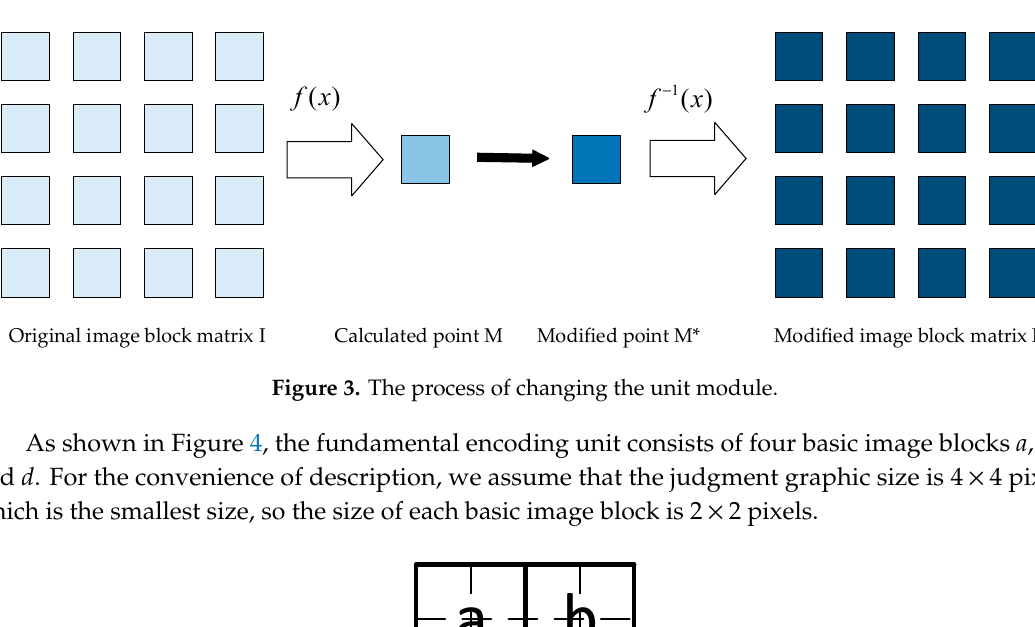
Figure 4. The fundamental encoding unit.